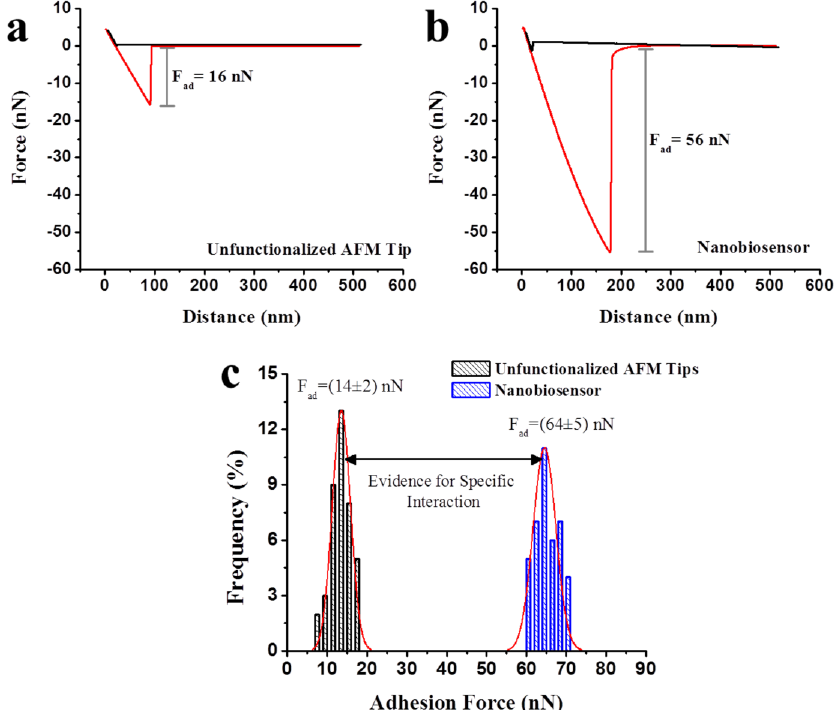
Figure 5. Example of typical force curves obtained using ( a ) an unfunctionalised tip, ( b ) a functionalised tip (nanobiosensor) and ( c ) histograms obtained for the values of the adhesion force (n = 5,000) when using unfunctionalised tips and nanobiosensors to analyse substrates covered with the herbicide